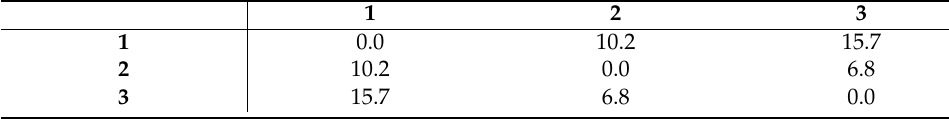
Table 4. Effort matrix E 3 for route three.